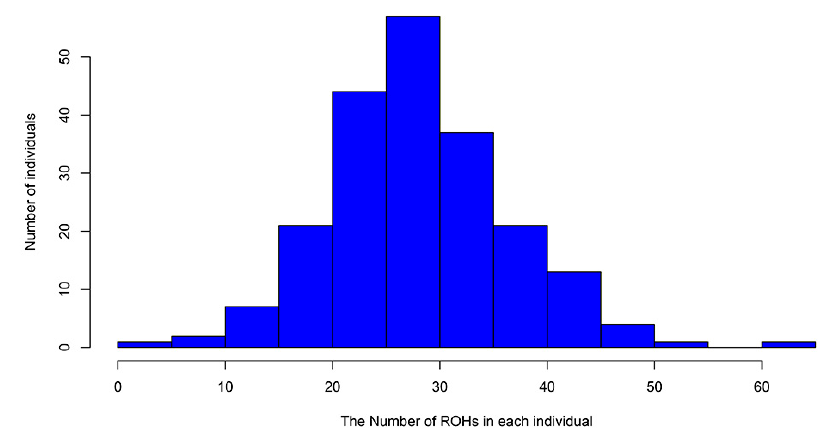
Figure 4. Frequency distribution of ROHs per chromosome (blue bars) and changes in the length of each chromosome (red lines).